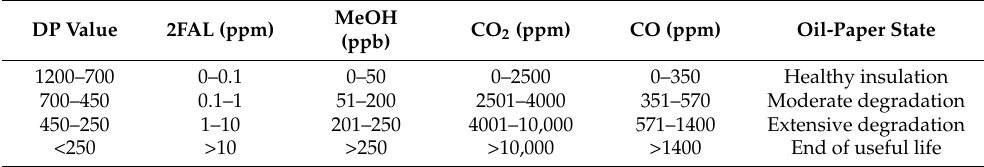
Table 1. Insulation condition based on chemical indicators